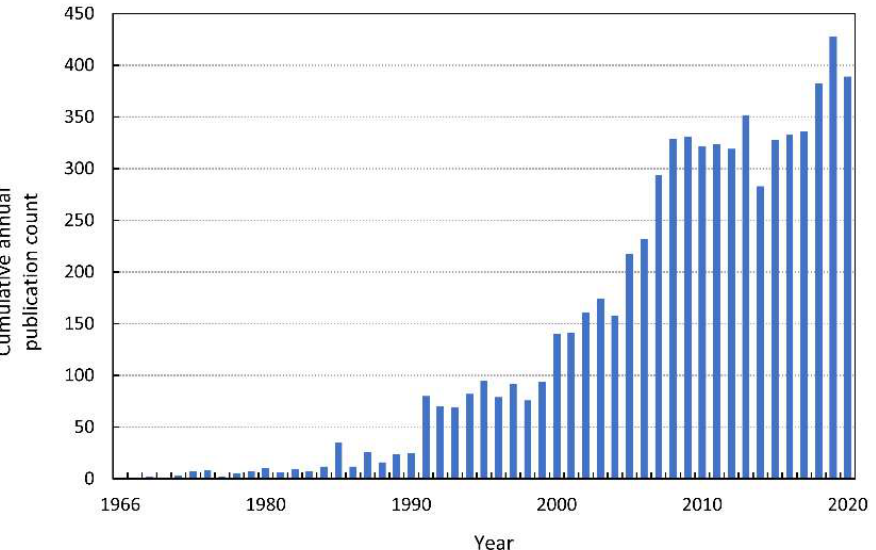
Figure 1. The cumulative annual publication count of papers on allelopathy. Details of the search are described in the Supplementary Materials.